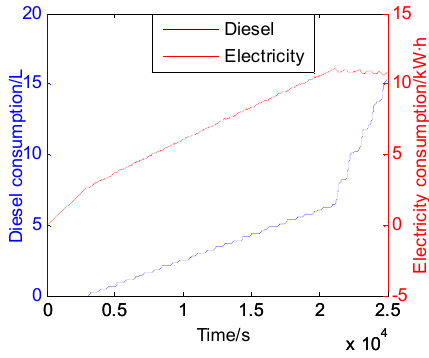
Figure 20. Diesel and electricity